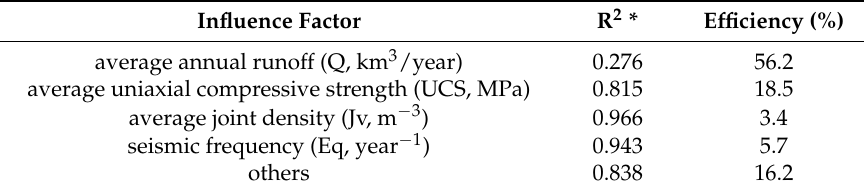
Table 1. Efficiency of each influence factor for sediment